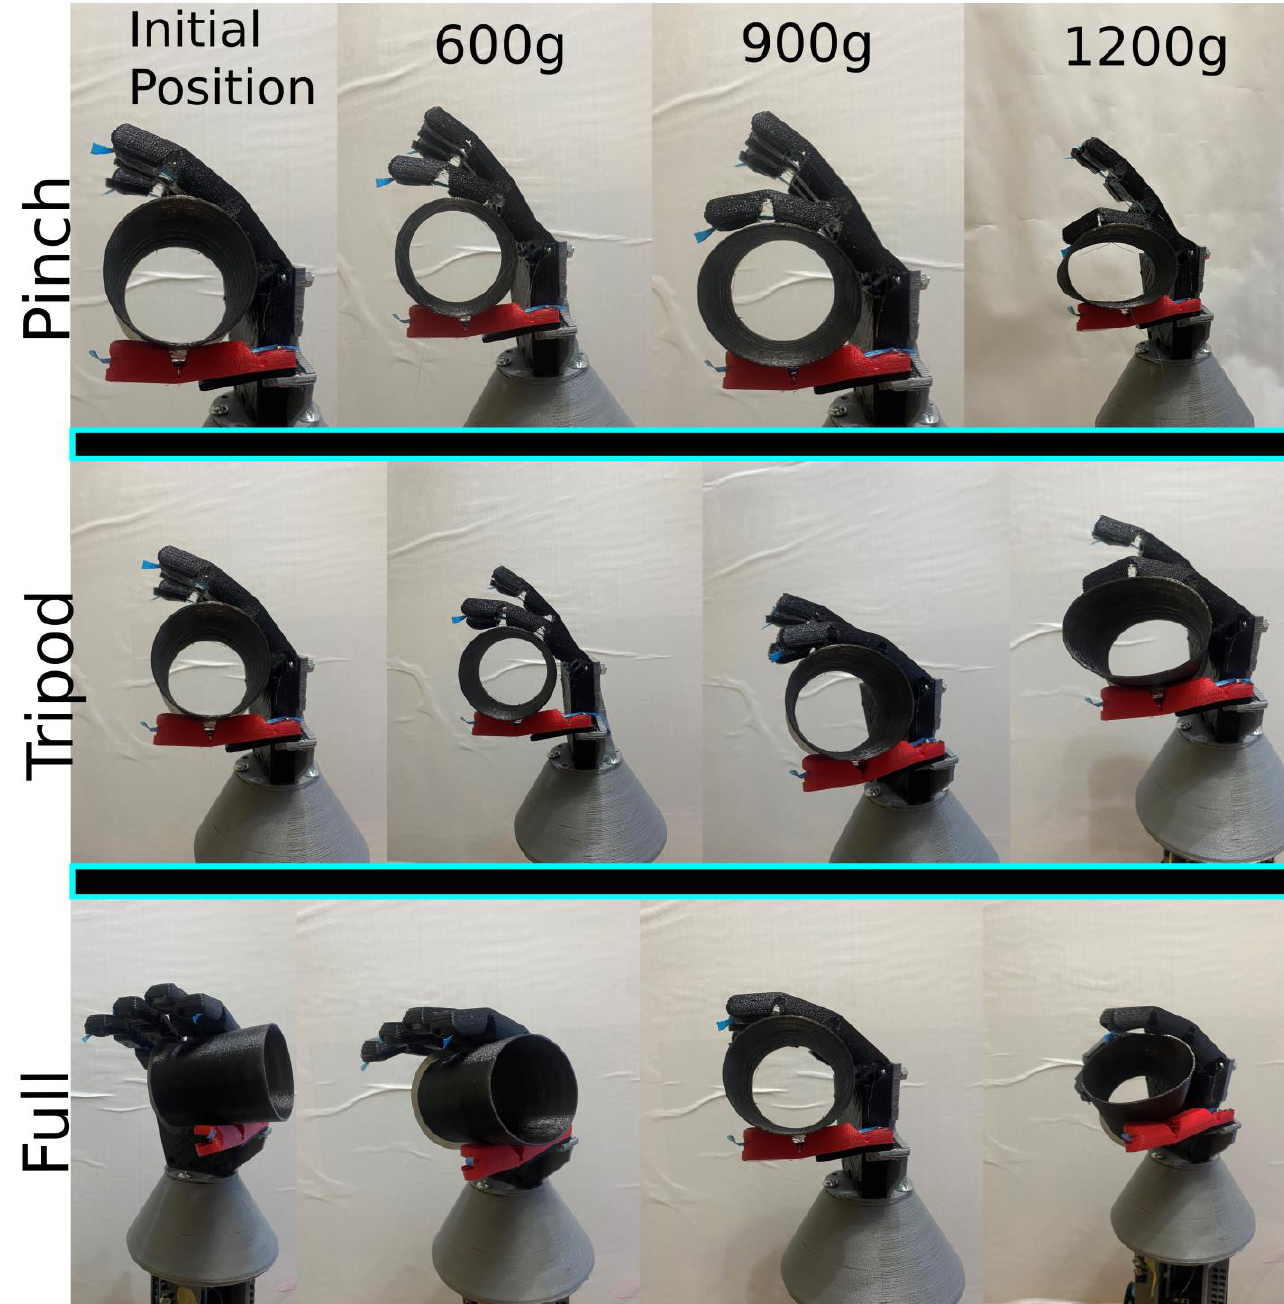
Figure 12. Images giving a visual demonstration of the performance of the proposed system and the developed force controller through the deformation of the flexible test object for setpoints of 600 g, 900 g, and 1200 g from left to right and for pinch, tripod, and full grasps from top to bottom, respectively. Additionally, the initial position of the hand before flexion is shown at the beginning of each row for reference and comparison of the smallest setpoint.